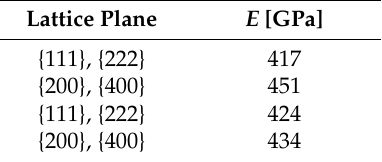
Table 1. The Young’s modulus values of TiN [22].